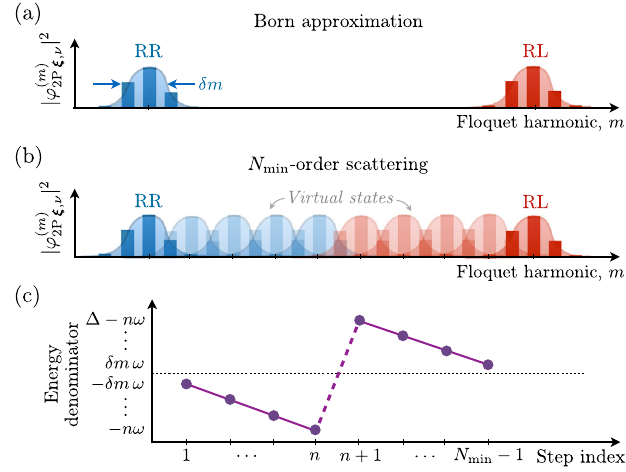
FIG. 3. Matrix elements and energy denominators for high- order scattering. (a) In the Born approximation, the RR → RL scattering matrix element is (super) exponentially suppressed by the small overlap of harmonic-space wave functions. (b) At an ∼ Δ = ð δ m ω Þ in perturbation theory, a nonsuppressed order N min matrix element between initial and final states for the RR → RL process is constructed by moving through a sequence of off-shell intermediate states, shifted away from one another by δν ≲ δ m harmonics. (c) Energy denominators for the virtual states in the process described in (b). Multiplying these energy denominators gives the expression in Eq.